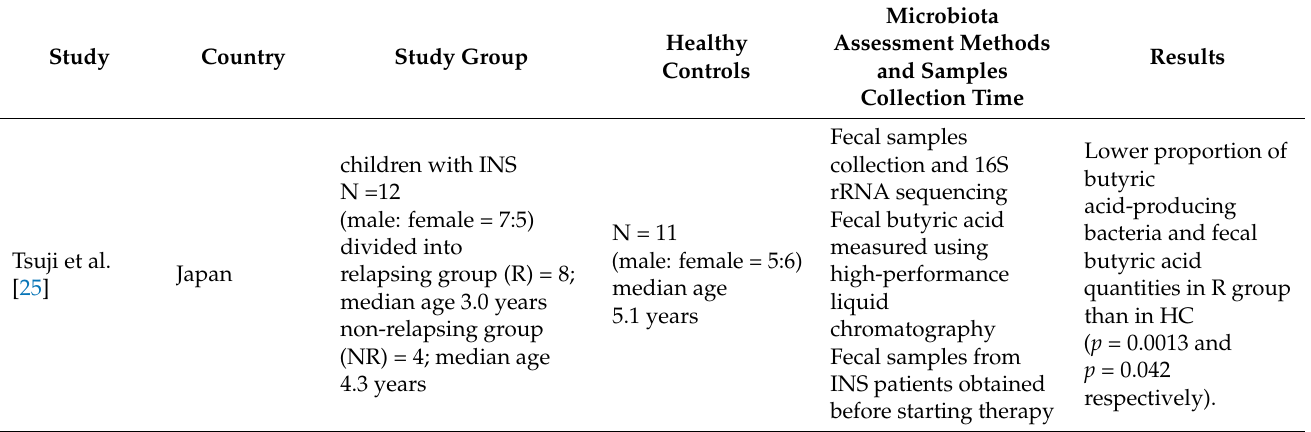
Table 1. Gut microbiota alterations in children with idiopathic nephrotic syndrome (INS) compared to healthy controls